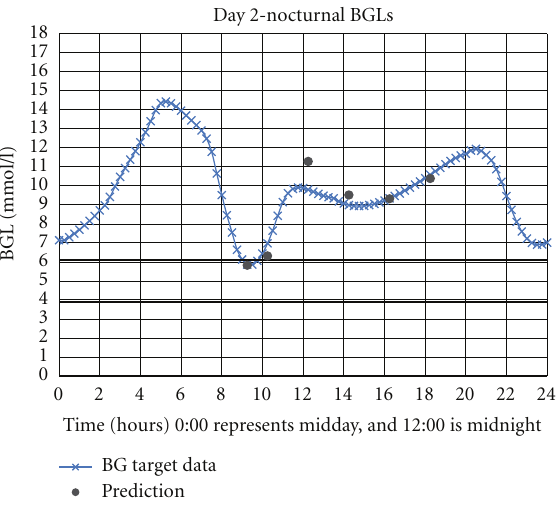
Figure 9: Predictions from trained ANNs on a test day which was not used during AIDA training. Each point represents a separate ANN, which was the best performing ANN over the 5 test days for a given prediction period.